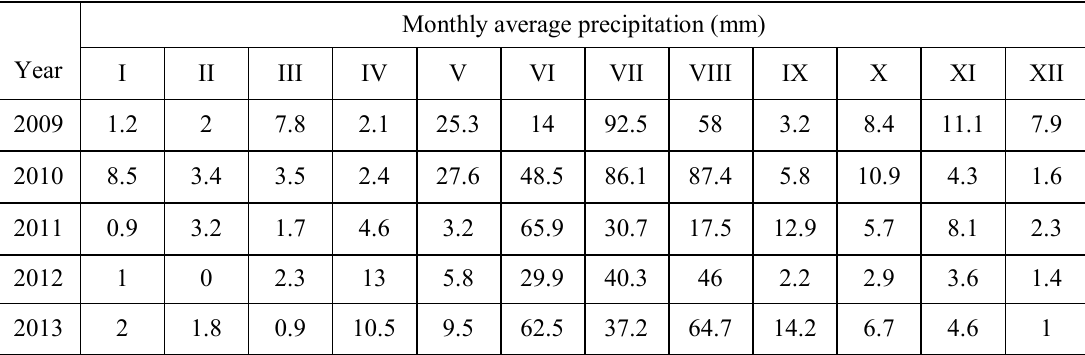
Table 1. Precipitation at Jargalant meteorological station Monthly average precipitation (mm)